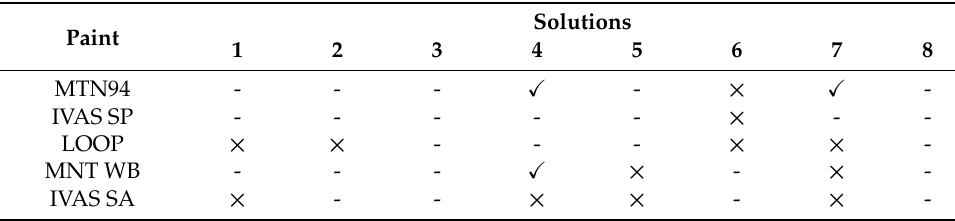
Table 5. Solubility tests on vandalism removal over selected Figure 7. Cleaning test carried out by wiping the vandalized surface with a mixture of solvents.